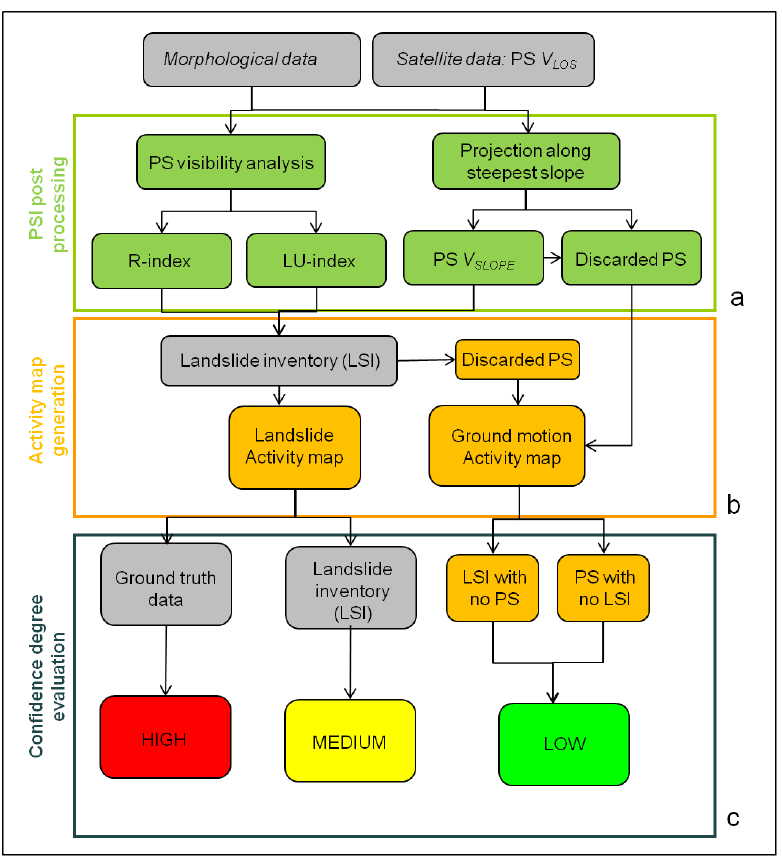
Figure 2. Methodology flow chart: ( a ) PSI post-processing phase, ( b ) Activity map generation, ( c ) Confidence degree